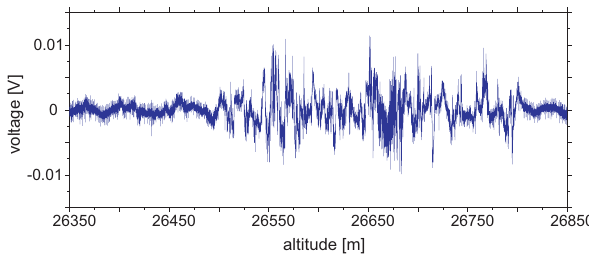
Table 1. Overview of launched LITOS payloads.